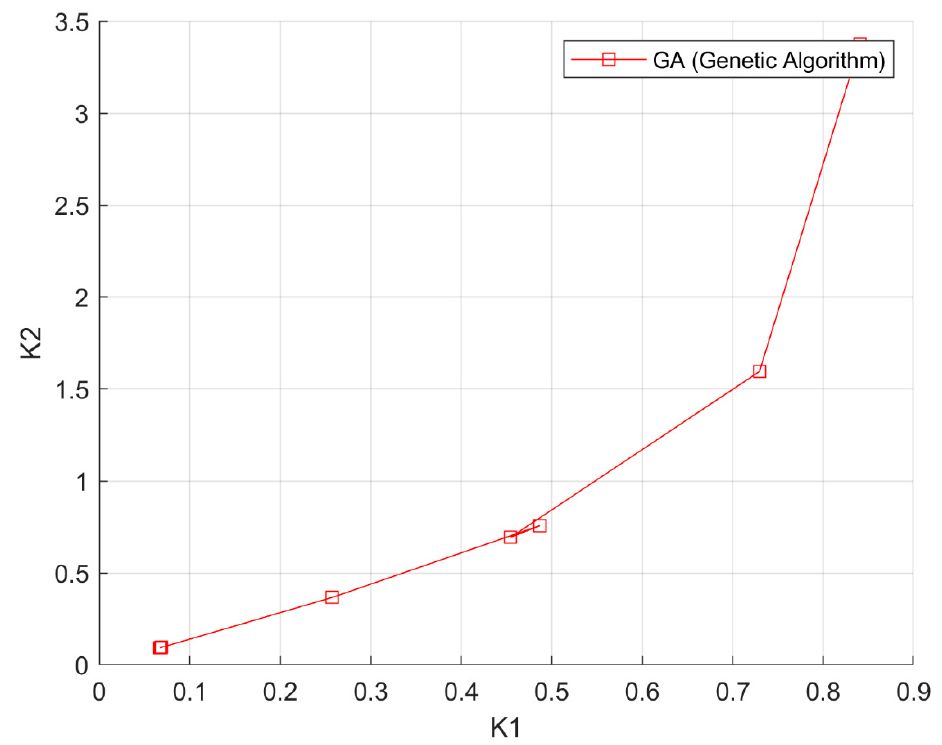
Figure 2. Pareto-optimal set for solving a problem by a method using a genetic algorithm.